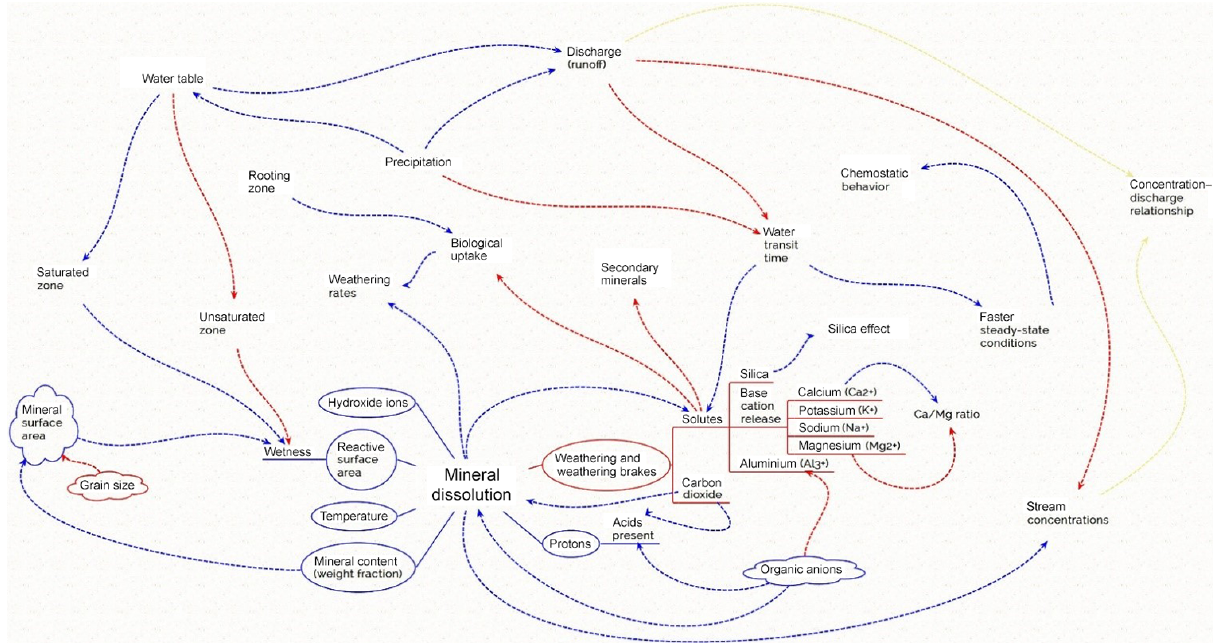
Figure 1. Sketch of possible interactions and feedbacks in soil during mineral dissolution. The mineral dissolution rate is affected by several physical (e.g., grain size and temperature), biological (e.g., cation uptake) and chemical (e.g., the presence of protons, organic acids and ions) parameters, some of which are connected to feedback loops from other related processes. Weathering brakes that slow down mineral dissolution are affected by the presence of different dissolved ions and compounds (organic acids and dissolved carbon dioxide) which, in turn, are affected by water fluxes and biological uptake. Water fluxes are driven by rainfall and runoff, leading to water table variations and, thus, changes in the soil water content and soil water solute concentration in general. Some of the feedbacks (marked in red) are negative feedbacks implying a reduction, whereas others are positive feedbacks (marked in blue). Derived terms such as concentration– discharge relationships that result from the interactions are marked in yellow. As a result, the weathering rate will be augmented through high biological uptake, reactive surface area, wet soil, temperature, secondary mineral formation in presence of organic acids at an acidic pH and large water fluxes causing low cation